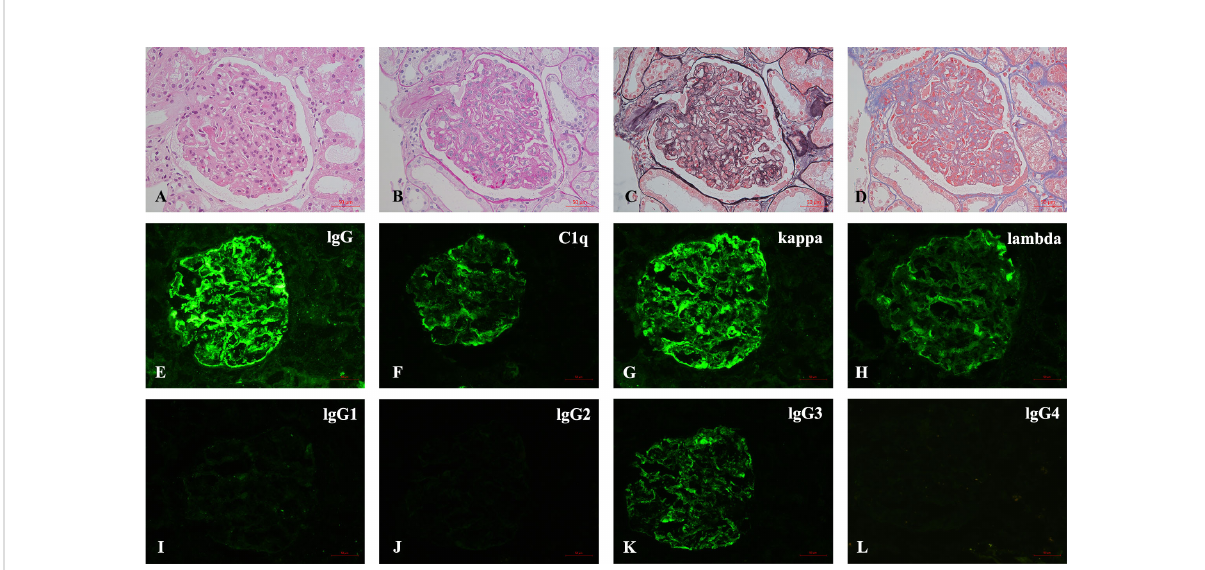
FIGURE 1 (A – L) Pathological fi ndings of renal biopsy. (A – D) Light microscopy shows a MPGN pattern of glomerular lesion (A) , HE; (B) , PAS; (C) , PASM; (D) , MASSON, 400×). (E – L) Immuno fl uorescence depicts granular mesangial and wall deposits with IgG, C1q, kappa, lambda, IgG3, and IgG2 trace, while IgG1 and IgG4 are negative [ (E – L) ,